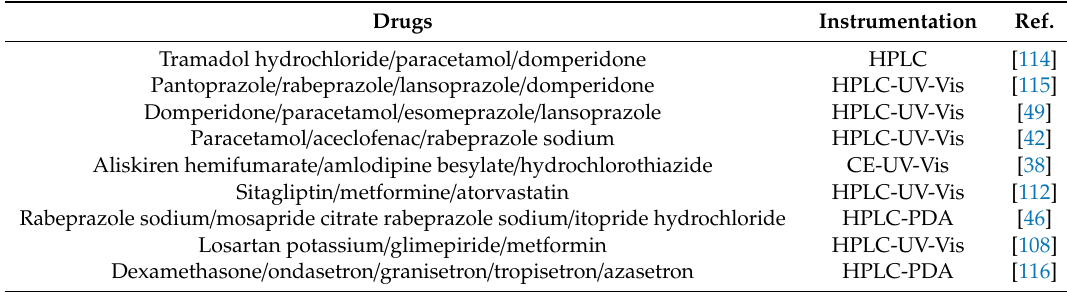
Table5. Analyticalproceduresdevelopedandvalidatedformultidrug(n ≥ 3)-associationco-formulation analyses in mixture or other